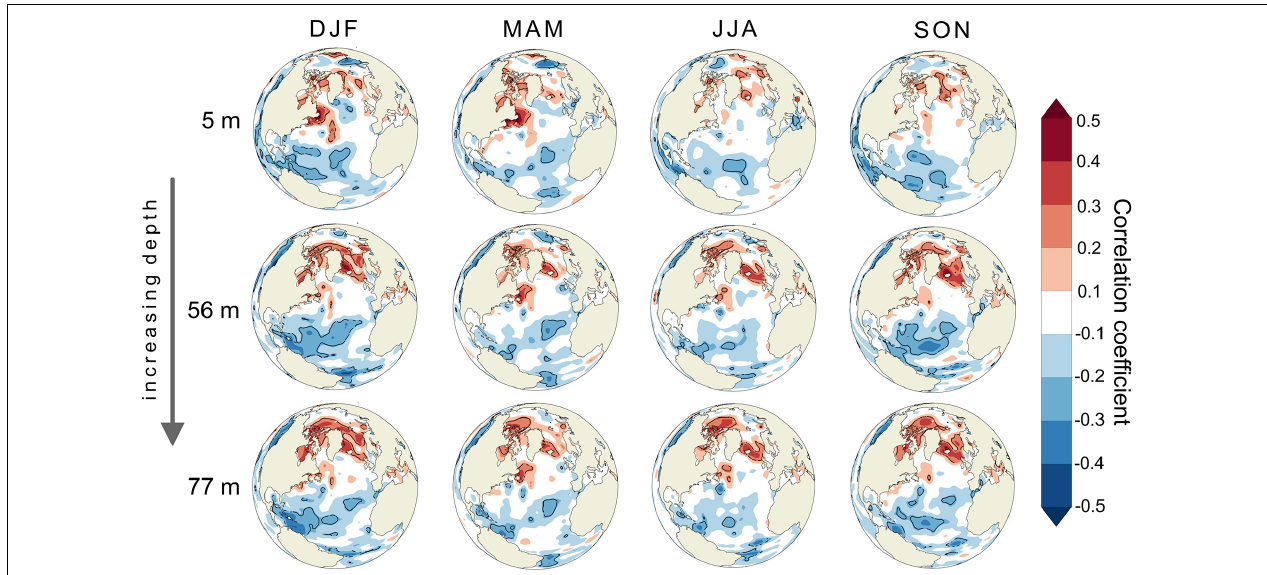
FIGURE 4 | Depth-dependent seasonal variability of growth index time series with water temperature at three different water depths (i.e., 5, 56, and 77 m) for 1900–2005 analysis period. Color shading shows the Pearson correlation coefficient ( p < 0.05) between ARMC and seasonal water temperature time series at each grid